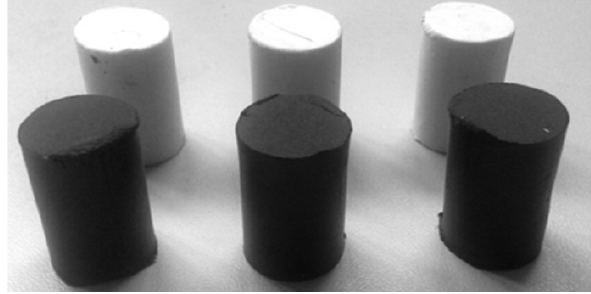
Figure 2: Exemplary samples from plasticine for tests.